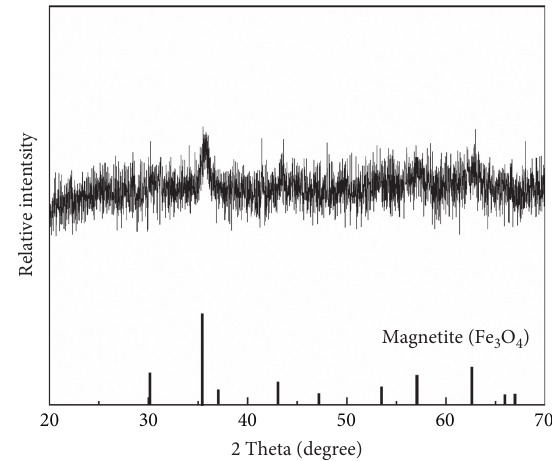
Figure 2: XRD pattern of the AC/Fe